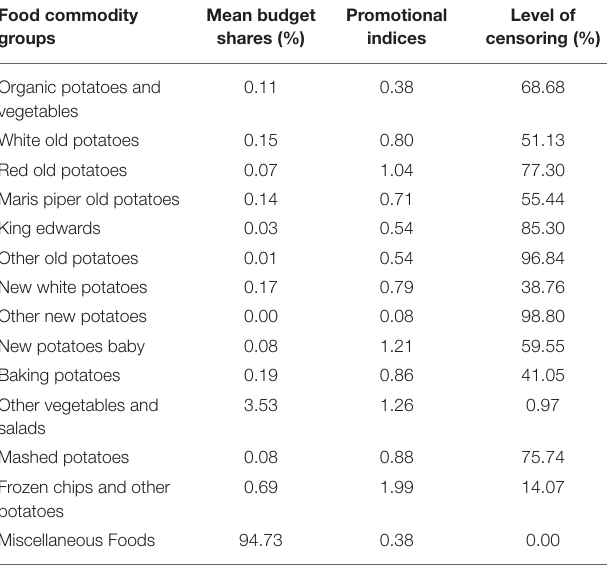
TABLE 1 | Commodity group composition and summary